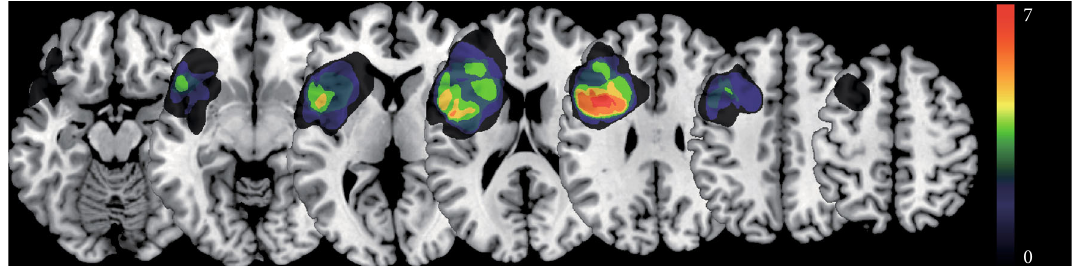
Figure 1: Lesion overlay of the 14 patients. Colors represent the number of patients with a lesion in the area. Warmer colors indicate a greater overlap.